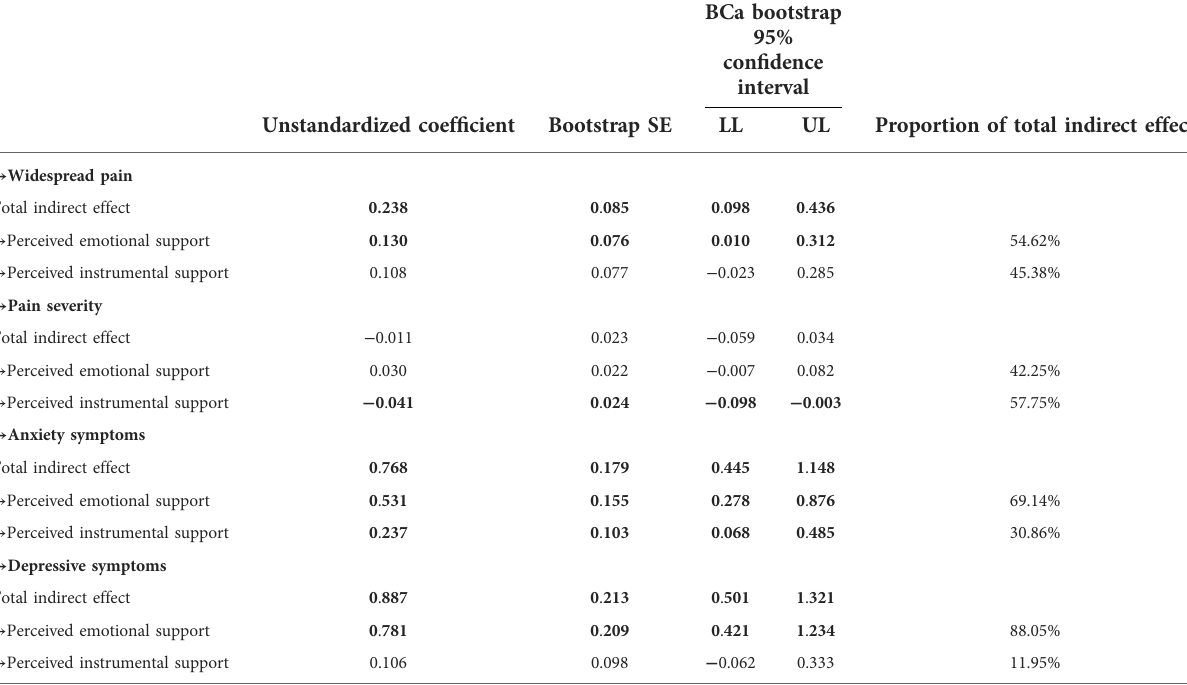
TABLE 3 Total and speci fi c indirect effects, bootstrap standard errors, and bias-corrected and accelerated 95% con fi dence intervals for mediation model of the association between history of childhood abuse and pain-related characteristics ( n =1,349).